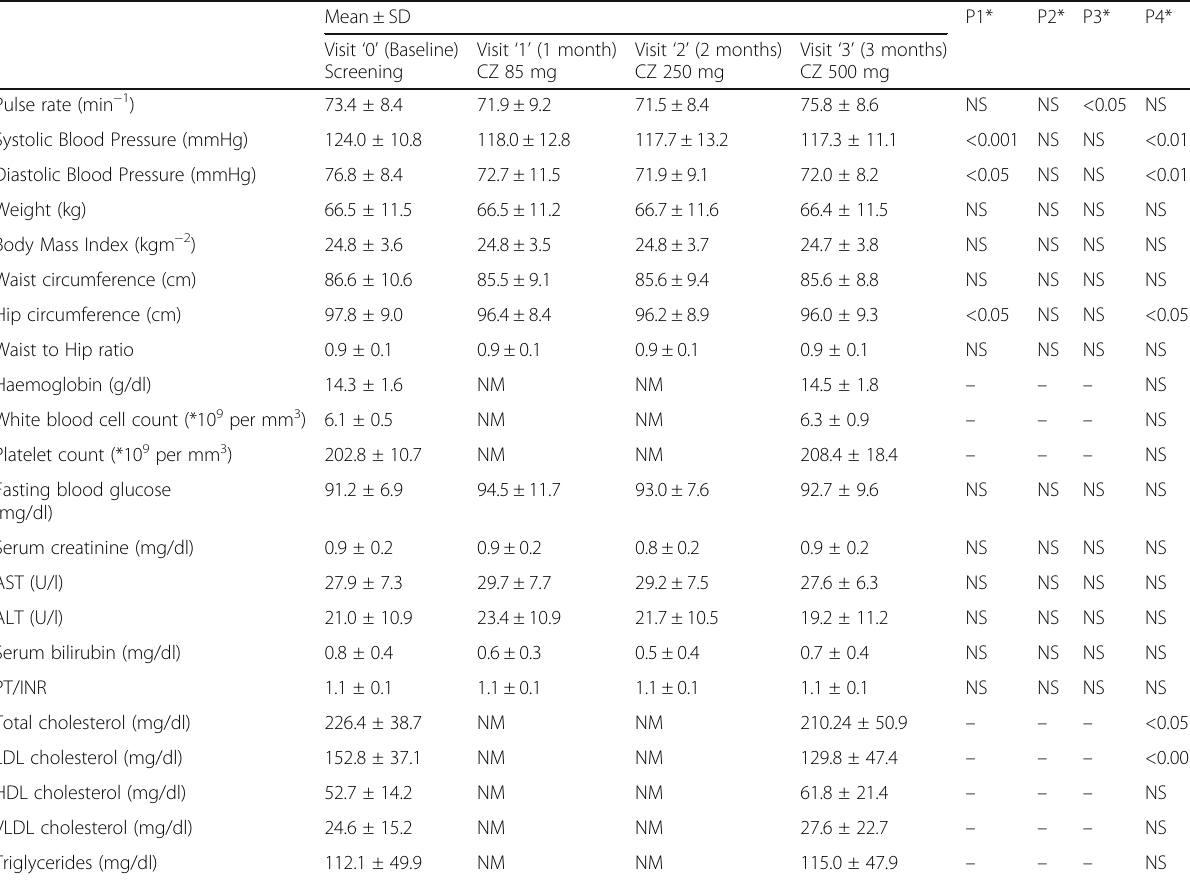
Table 3 Clinical and biochemical assessment during follow